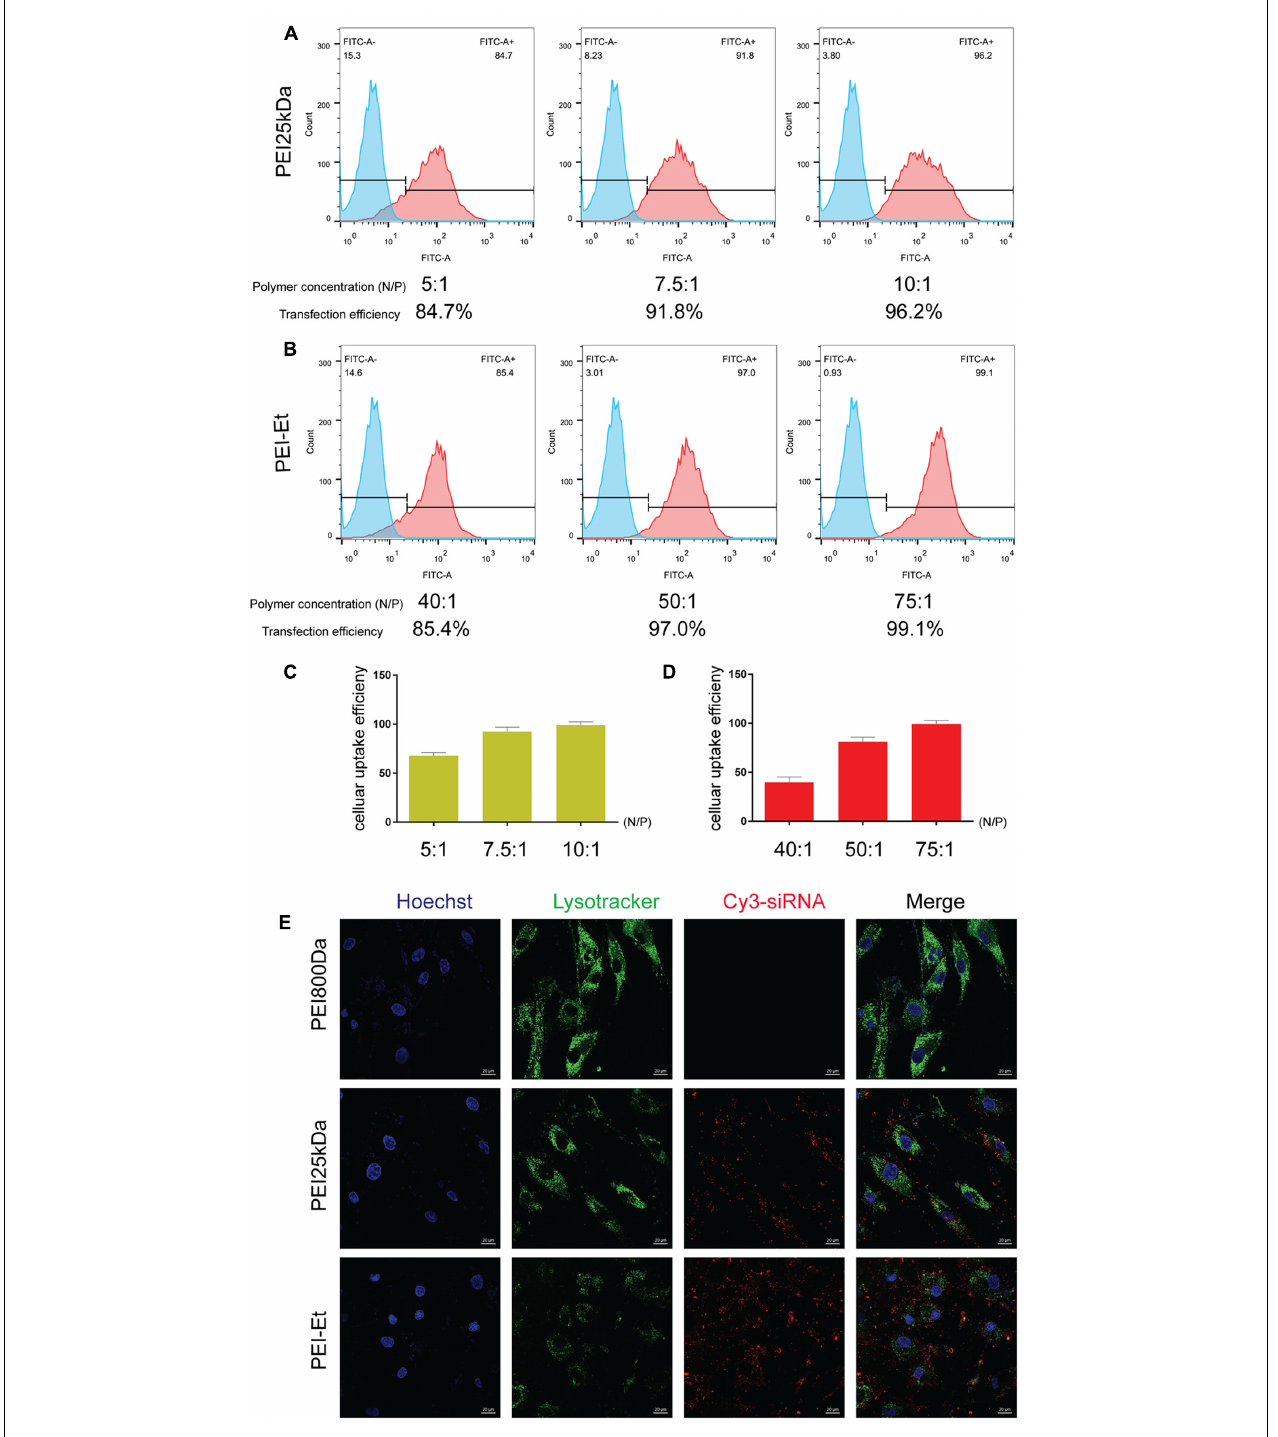
FIGURE 3 | Cellular uptake efficiency of PEI-Et in delivering siRNA into hBMSCs. (A) Representative flow cytometry images of cellular uptake efficiency of PEI25kDa/siRNA polyplexes at different N/P ratios (5:1, 7.5:1, and 10:1). (B) Representative flow cytometry images of cellular uptake efficiency of PEI-Et/siRNA polyplexes at different N/P ratios (40:1, 50:1, and75:1). (C) Quantitative analysis cellular uptake efficiency of PEI25kDa/siRNA polyplexes at different N/P ratios (5:1, 7.5:1, and 10:1). Data are presented as mean ± SD of three independent experiments, N = 3. (D) Quantitative analysis cellular uptake efficiency of PEI-Et/siRNA polyplexes at different N/P ratios (40:1, 50:1, and 75:1). Data are presented as mean ± SD of three independent experiments, N = 3. (E) Cellular uptake of PEI800/Cy3-siRNA, PEI25kDa/Cy3-siRNA and PEI-Et/Cy3-siRNA polyplexes measured by laser confocal microscopy. Red: polyplexes; Blue: cell nucleus, Green: lysosome. The scale is 20 µ